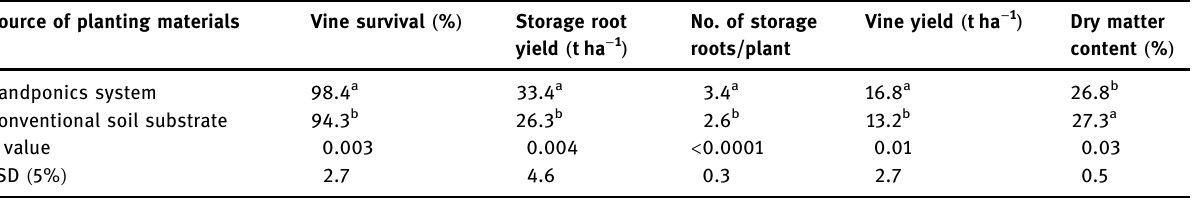
Table 4: Mean values for vine survival, storage root yield, number of storage roots per plant, vine yield, and dry matter content as a ff ected by source of planting materials Source of planting materials